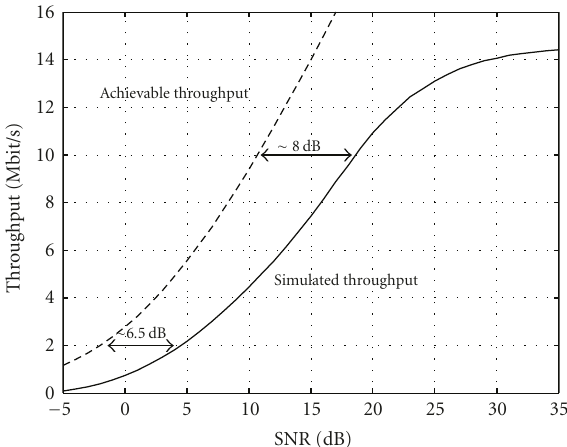
Figure 13: Simulated throughput performance of the SISO system with perfect channel knowledge in a flat Rayleigh fading